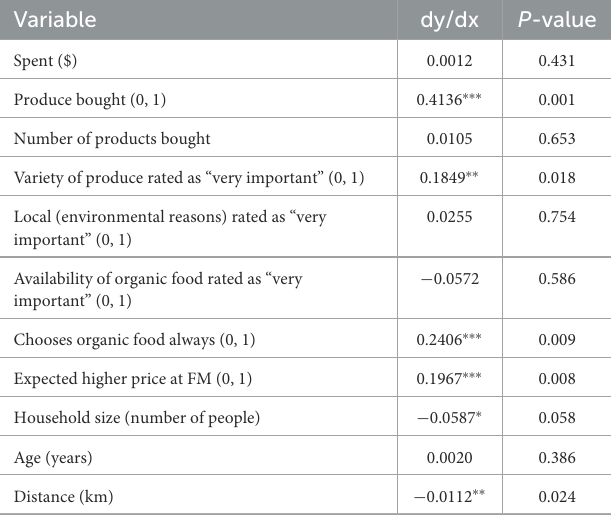
TABLE 8 Logistical regression model of regulars (weekly or biweekly) as dependent variable, n = 206 + .